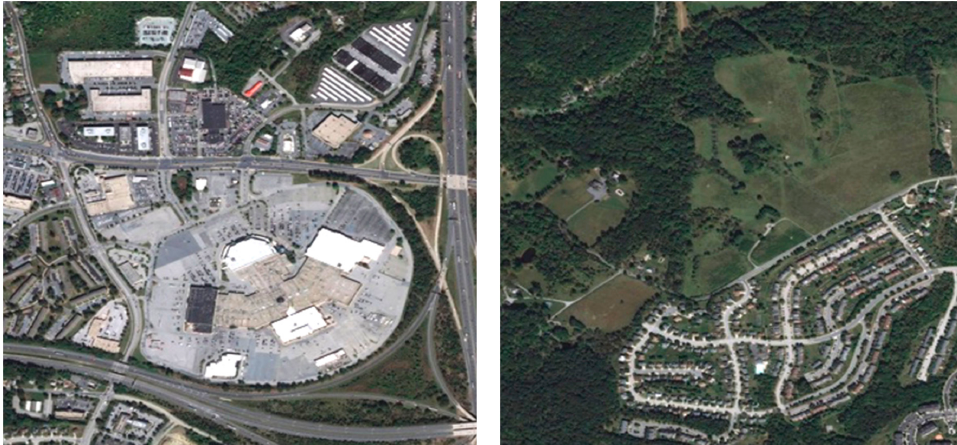
Figure 2. Illustration of urban and non-urban areas based on the definition of urban areas employed in this study. The size of the square is 1 km by 1 km: urban area contains more than 50% of built-up areas ( left ) while a non-urban area contains less than 50% built-up area ( right